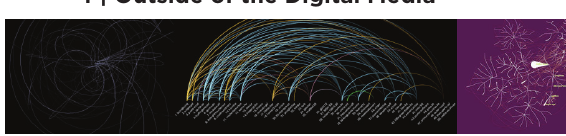
Figure 3 : Visualization by Ben